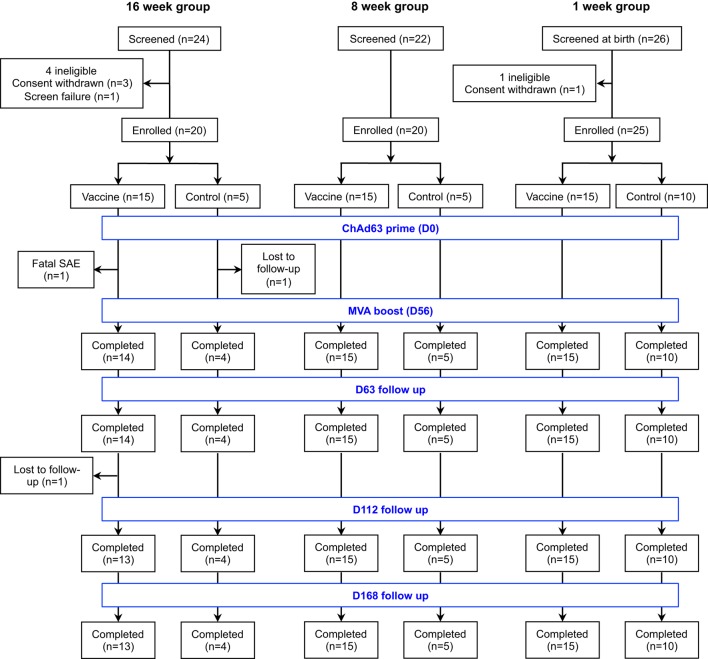
Flow of study design and volunteer enrollment. Seventy-two infants and neonates were screened for eligibility across the three age groups and 65 eligible infants were enrolled, randomized, vaccinated according to randomization list and followed up for 252 days. Of 24 infants screened in the 16-week-old group, mothers of 3 infants withdrew consent before enrollment while 1 infant was excluded due to markedly raised alanine transaminase. Among those randomized to the vaccine arm, one infant had fatal SAE that was non-related to the study vaccines and another was lost to follow-up due to relocation of mother, while only one infant did not complete the follow-up in the control arm. Twenty-two infants were screened for the 8-week-old cohort and all were eligible. Only the first 20 were randomized into 15 vaccine group and 5 controls. Similarly, 26 mother-newborn pairs were screened for the 1-week-old group. A mother withdrew consent before enrollment and the remaining 25 neonates were randomized into 15 vaccinees and 10 controls. All study infants in the 8- and 1-week-old groups completed the study follow-up. SAE, serious adverse event.